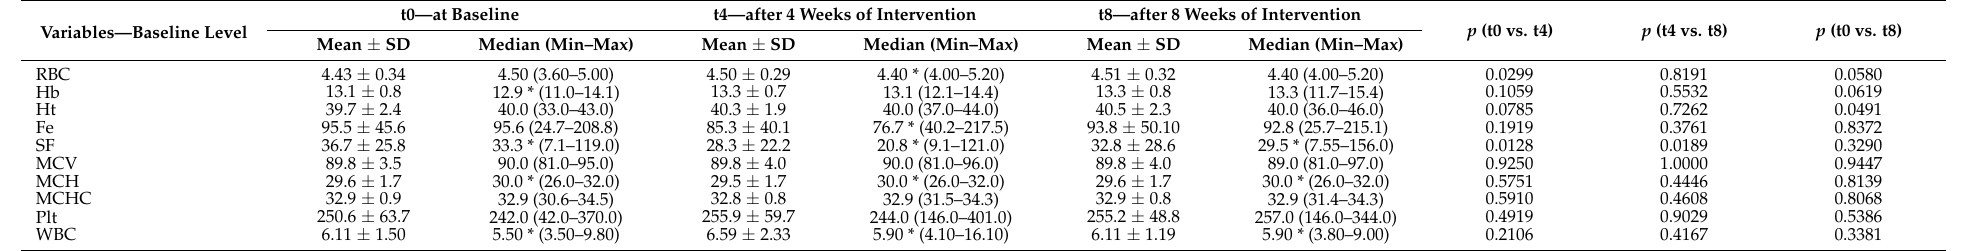
Table 3. The iron status of the participants of the study ( n = 29), accompanied by the other hematological parameters, throughout the study period.